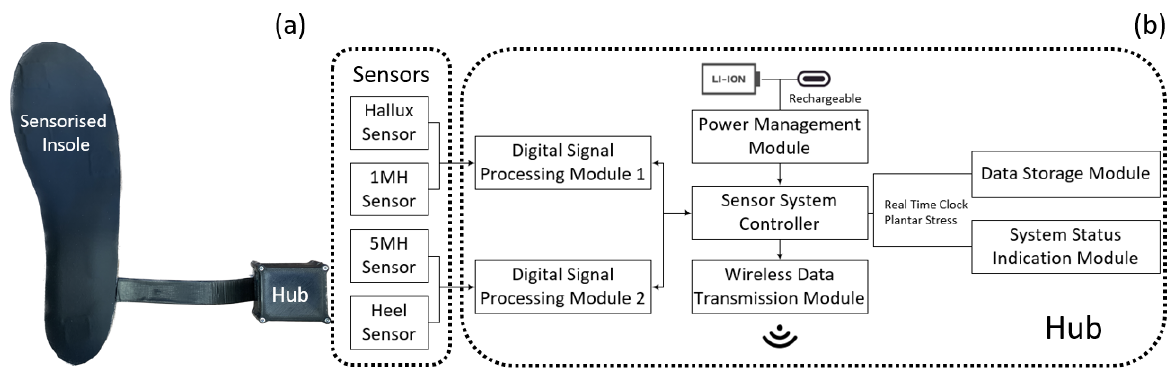
Figure 2. ( a ) A photo of the sensorised insole system and ( b ) a diagram illustrating key function modules within the hub.